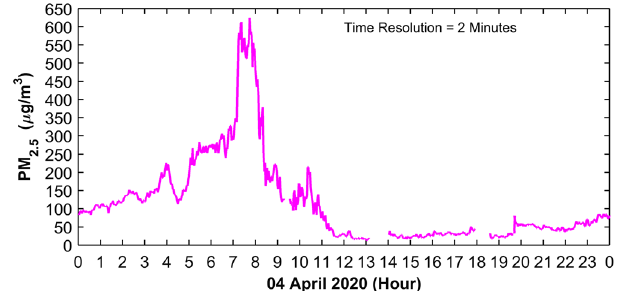
Figure 5. High resolution monitoring (averaged over 2 min interval) of PM 2.5 shown since morning to evening. On 4 April 2020 from 0500 to 0700 IST haze prevailed. After sunrise, around 0710 IST, within 20 min (0730 IST onwards) further a steep and step increase of about 100–300 µg m −3 in PM 2.5 took place, which lasted for about an hour. Steep and step wise increase was a common feature for several days. As soon as solar radiation increased above 300 W m −2 , and wind speed increased around 1000 IST, sudden decline in PM 2.5 observed up to 20 µg m −3